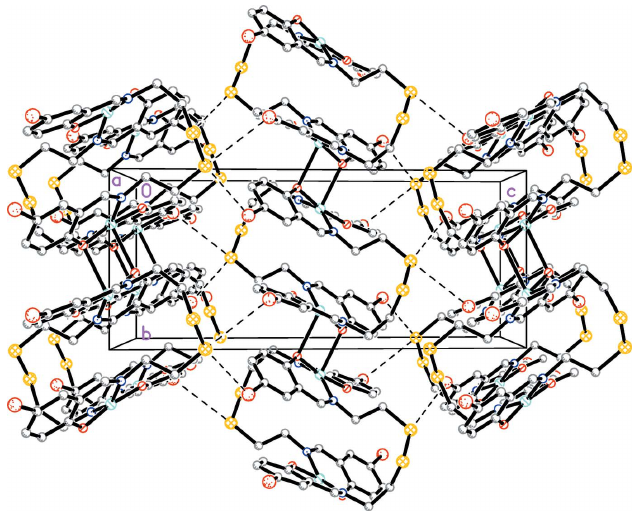
Figure 2 The crystal packing of the title compound viewed along the a axis. Short S (cid:2)(cid:2)(cid:2) Br contacts are shown as dashed lines. H atoms are not shown.